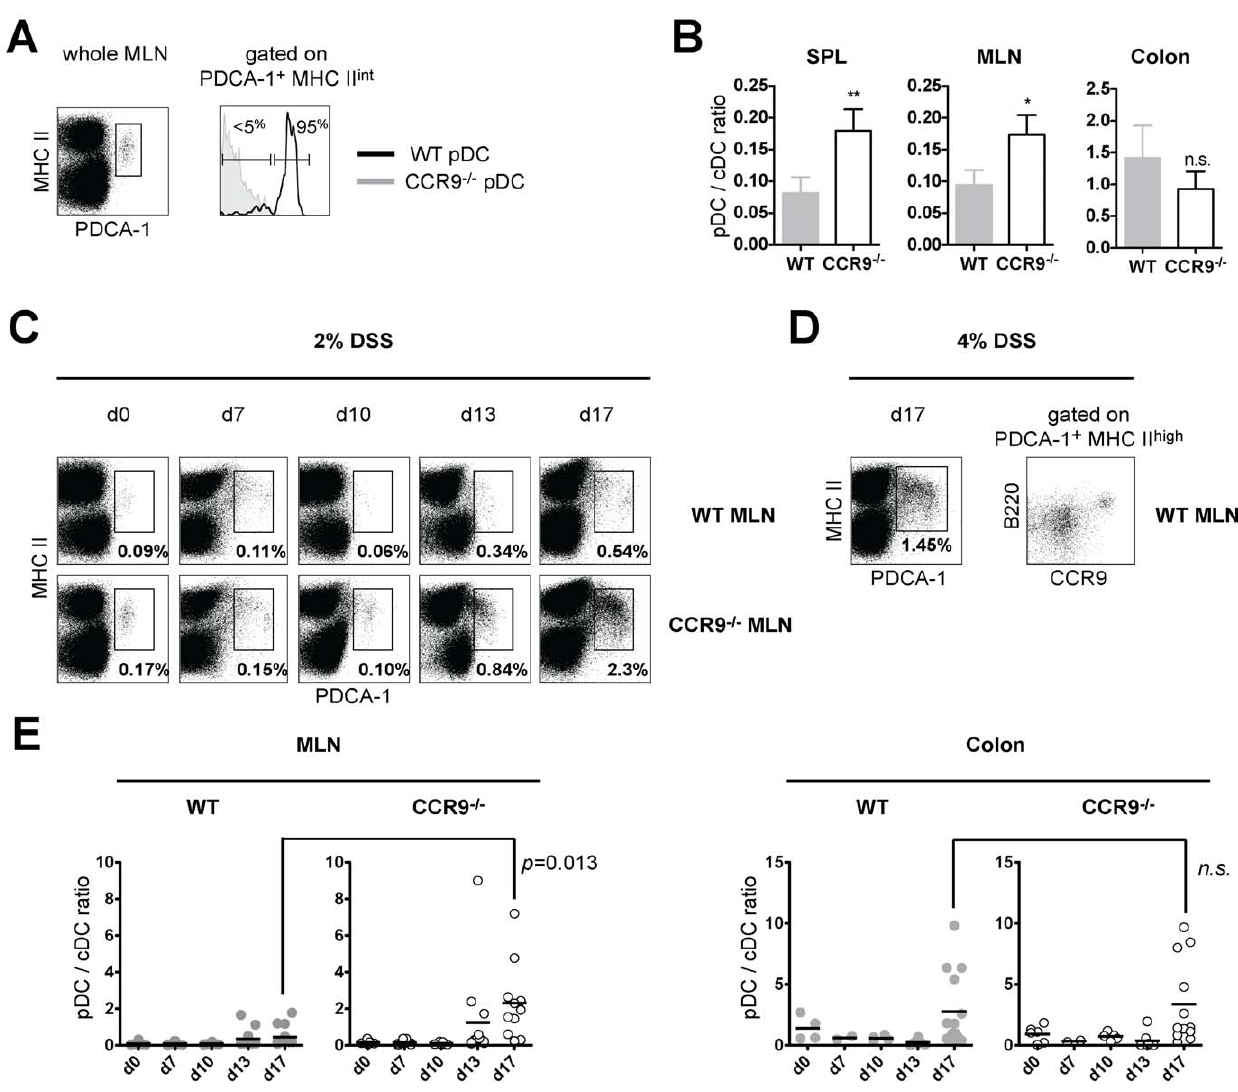
Figure 5. CCR9 2 / 2 mice show altered ratios of dendritic cell subpopulations at steady state and during DSS-mediated colitis. ( A ) WT MLNs contain CCR9 + and CCR9 2 pDCs gated as MHC II int and PDCA-1 high (left dot plot). CCR9 expression in WT pDCs (black line, right histogram) is overlaid on CCR9 2 / 2 pDCs (in gray, right histogram) ( B ) Steady state distribution of pDCs and cDCs is altered in SPL and MLN of CCR9 2 / 2 mice. No significant difference between strains is observed in the colon. cDCs were defined as CD11c high and MHC II high cells by flow cytometry. Ratio of subpopulations is expressed on the y-axis as pDC/cDC cells. Data represent the mean + / 2 SD of 4 independent experiments of 3–5 pooled mice per group. ( C ) Accumulation of pDCs in MLNs of CCR9 2 / 2 animals. Percentages of pDCs in WT and CCR9 2 / 2 MLN are depicted in bold from d0 to d17 of DSS colitis. ( D ) Accumulation of pDCs correlates with the level of tissue damage. Increase of DSS concentration to 4% augments the number of CCR9 low/ 2 B220 + PDCA-1 + MHC II int/high cells in MLNs of WT animals. ( E ) DSS-mediated tissue inflammation alters pDC/cDC ratios in MLN of CCR9 2 / 2 animals. Data points correspond to individual experiments corresponding to 17 DSS colitis experiments harvested at different time point using 3–5 pooled mice per